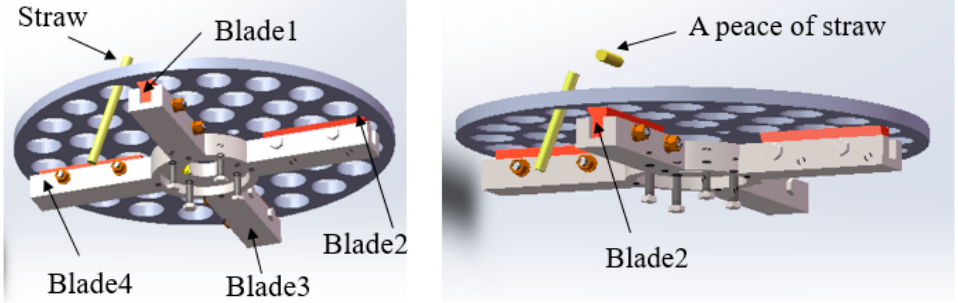
Figure 4. Cutting process of straw.